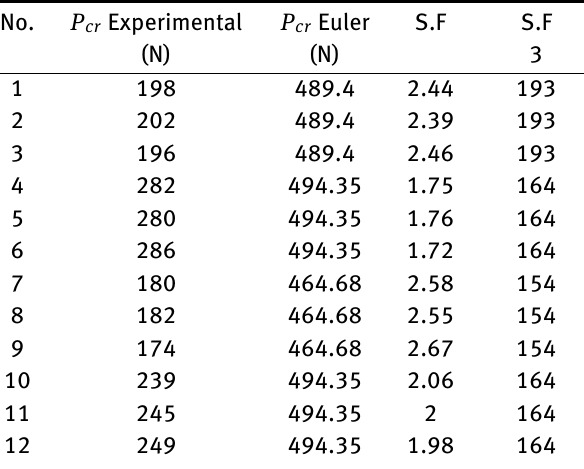
Table 7: Comparison between the experimental results and the Euler results for long specimens